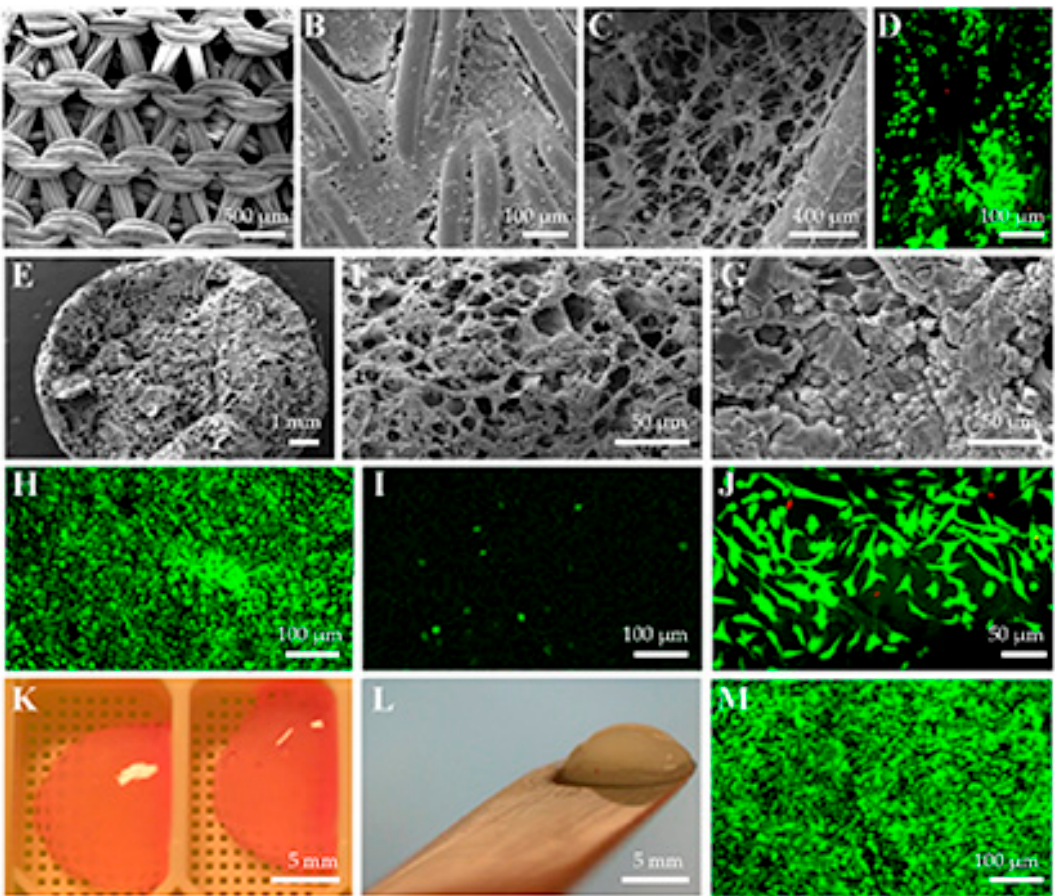
Figure 2. Examples of the use of recombinant human type II collagen as a biomaterial for primary chondrocytes. ( A ) The nonseeded knitted poly- L , D -lactic acid disc. ( B ) The surface of knitted poly- L , D -lactic acid disc filled with cross-linked recombinant human type II collagen seeded with primary chondrocytes. ( C ) The inner part of knitted poly- L , D -lactic acid disc filled with cross-linked recombinant human type II collagen seeded with primary chondrocytes. ( D ) The inner part of knitted poly- L , D -lactic acid disc filled with cross-linked recombinant human type II collagen seeded with primary chondrocytes and cultured with live/dead fluorochromes to visualize the live (green) and dead cells (red). ( E ) Recombinant human type II collagen sponge shows the porous structure of the material. ( F ) The porosity of recombinant human type II collagen sponge is also obvious inside the material. ( G ) The chondrocytes adhere well to the surface of recombinant human type II collagen sponge. ( H ) Live/dead staining indicates good cell viability on the surface of recombinant human type II collagen sponge. ( I ) However, only a few chondrocytes can reach the most inner part of recombinant human type II collagen sponge. ( J ) The chondrocytes seeded on the surface of recombinant human type II collagen membrane adhere well but show fibroblastic shapes and apparently dedifferentiated phenotype. ( K ) The chondrocytes mixed with soluble recombinant human type II collagen form the cell-embedded gels. ( L ) The chondrocyte seeded recombinant human type II collagen gels also stiffen during a two-week culture period. ( M ) The chondrocytes embedded in recombinant human type II collagen also have good cell viability for at least four weeks, as shown by live/dead staining.